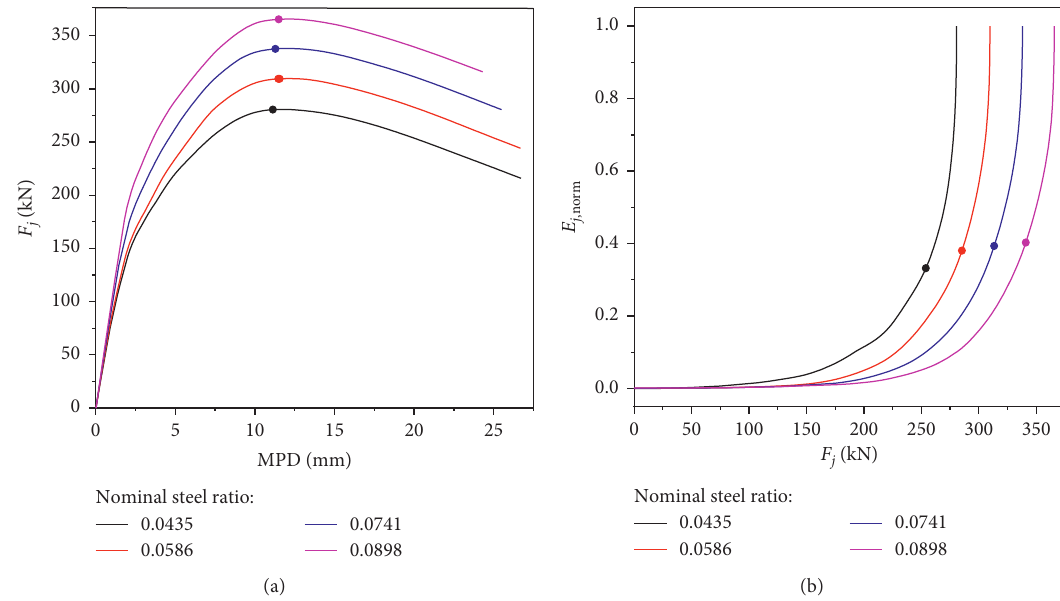
Figure 18: (a) F − Middle point deflection of the columns curves under different nominal steel ratio. (b) E j nominal steel ratio.